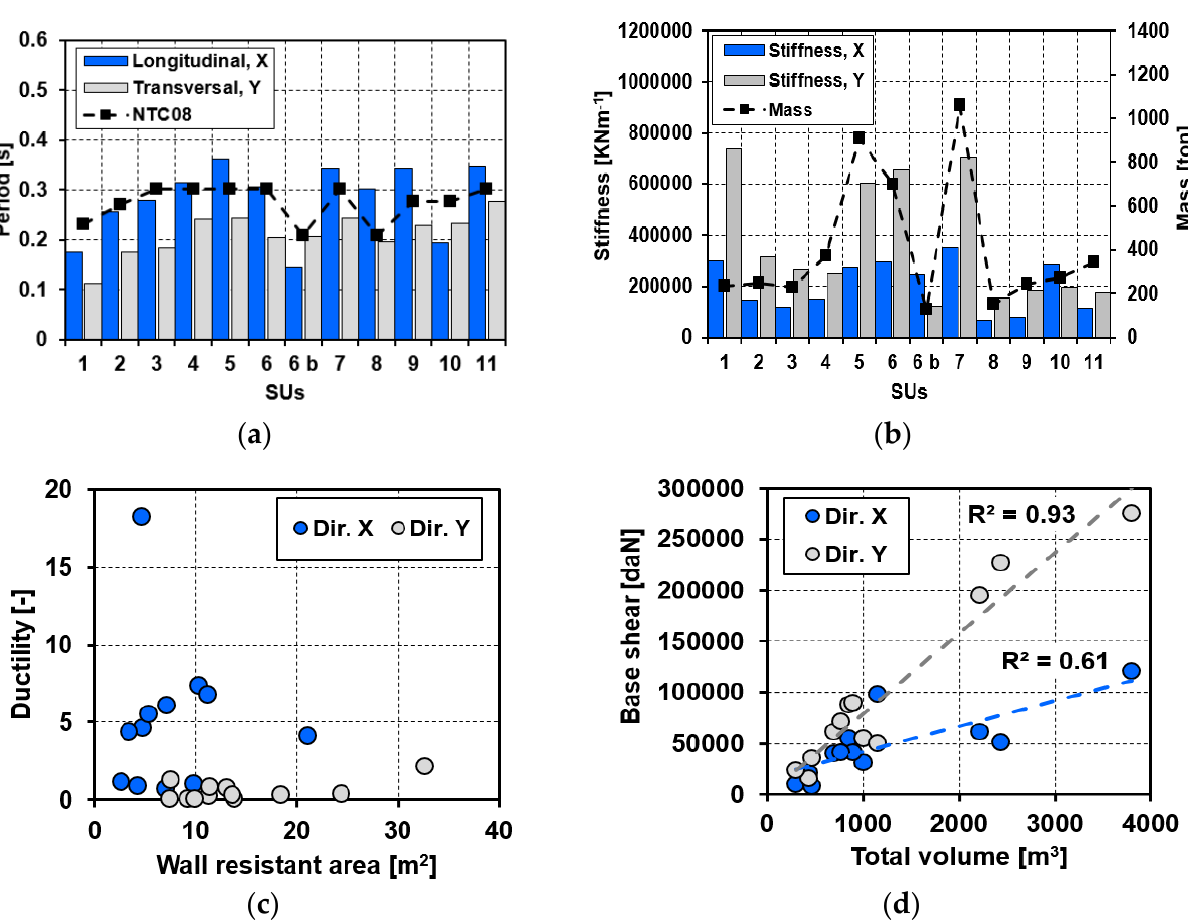
Figure 12. Capacity of the SUs in terms of ( a ) vibration period, ( b ) stiffness and mass, ( c ) ductility displacements vs. wall resistant area, and ( d ) base shear vs. total volume.